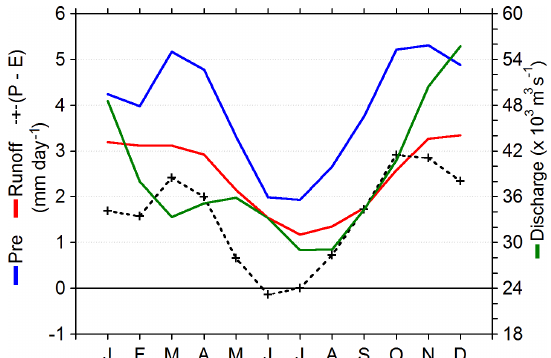
at the Bangui gauge station (Runge and Nguimalet, 2005).